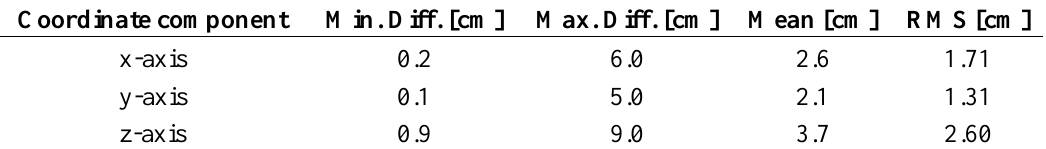
Table 6 . Analysis of differences between RTK GPS and terrestrial